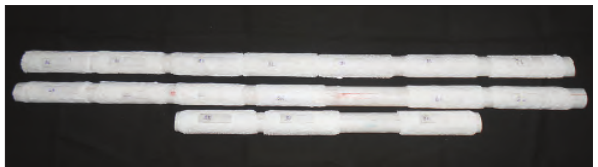
Figure-1: Construction of plaster of Paris cast on polyvinyl chloride mold.